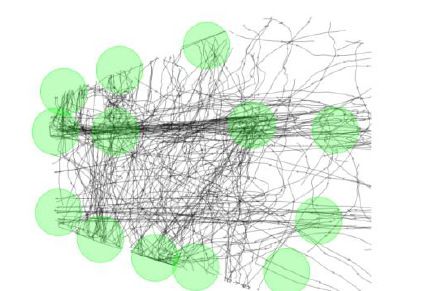
Figure 3: The extracted interesting places are results of the first